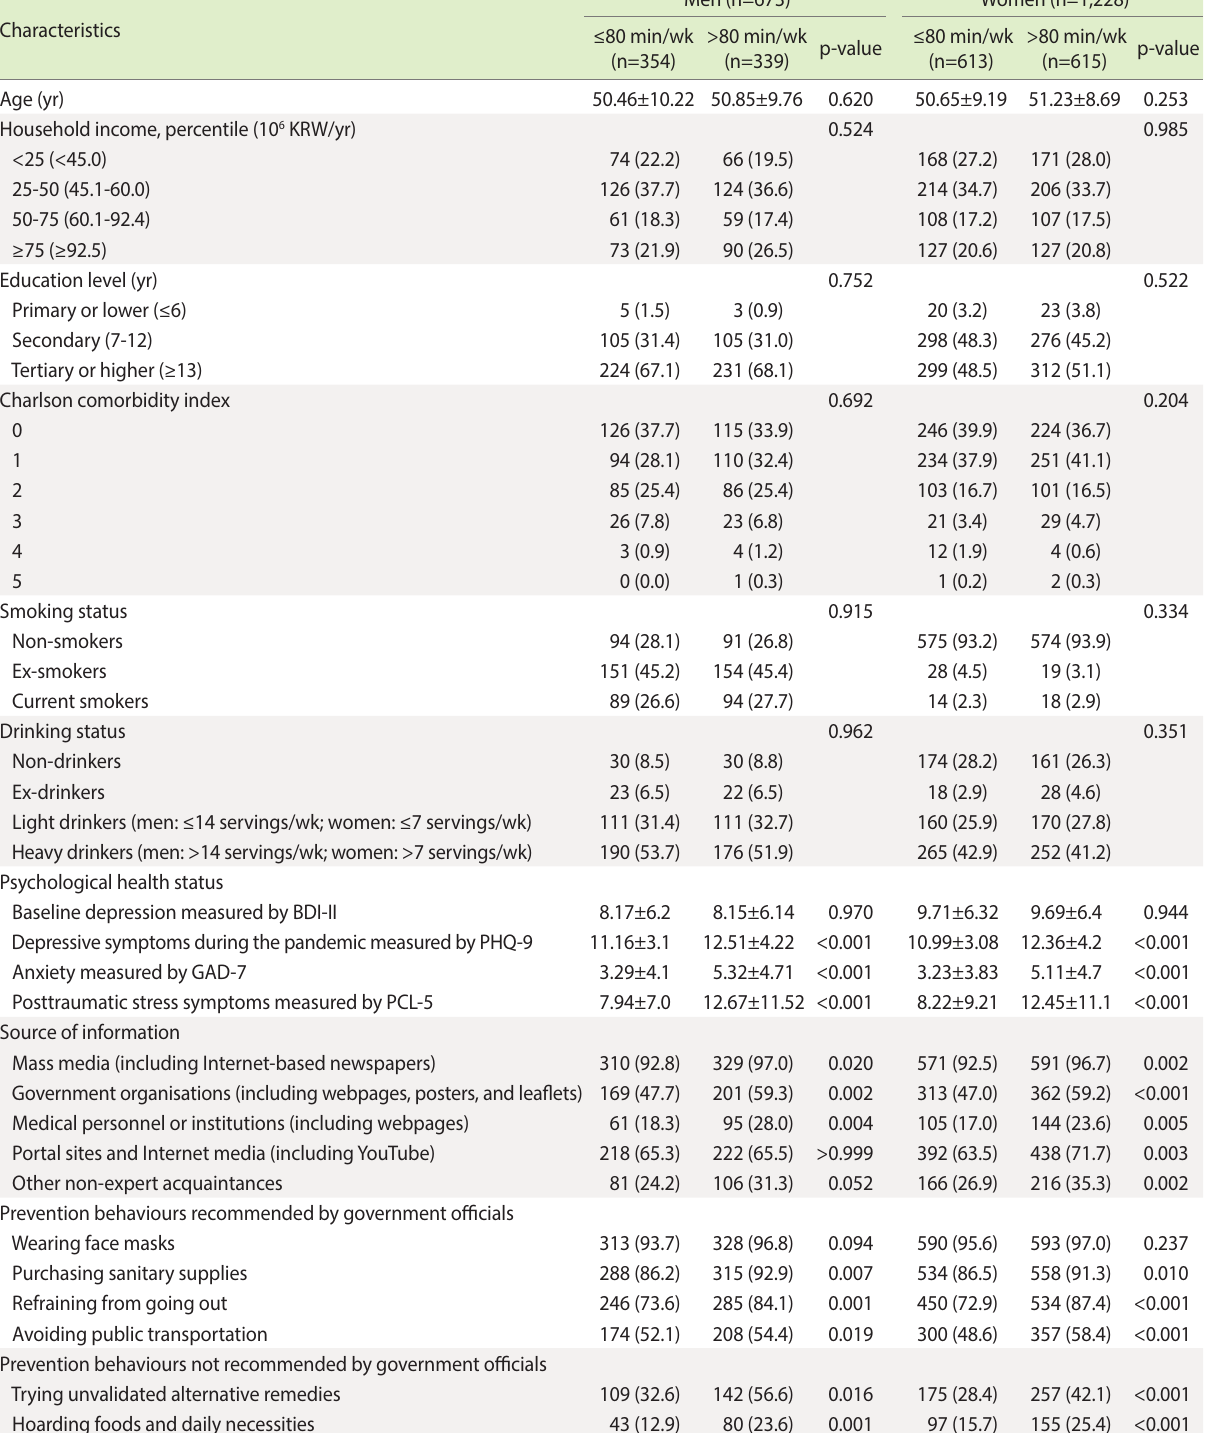
Table 1. Characteristics of the study population according to time spent seeking coronavirus disease 2019 (COVID-19)-related information